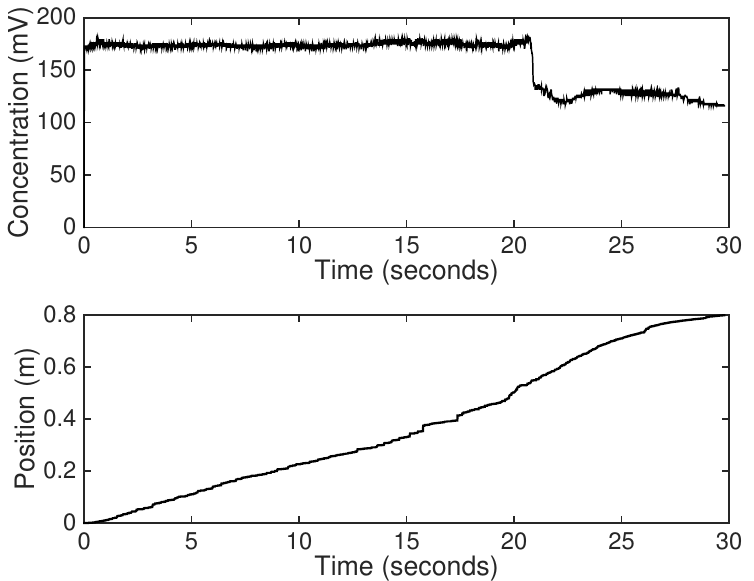
Figure A2. Experimental test for impedance measurement for glucose insertion. The targeted delivery concept has been implemented only through software due to the fact that the robot is not equipped with substance administration mechanisms. The nominal operating impedance value (175 mV) is compared to the measured value, detecting changes that outbound the [ − 20, 20 ] mV interval. In the case of significant impedance changes, the robot is programmed to stop at the desired position until the concentration values adjust to the accepted interval. It is considered that the robot administers the proper medication while being